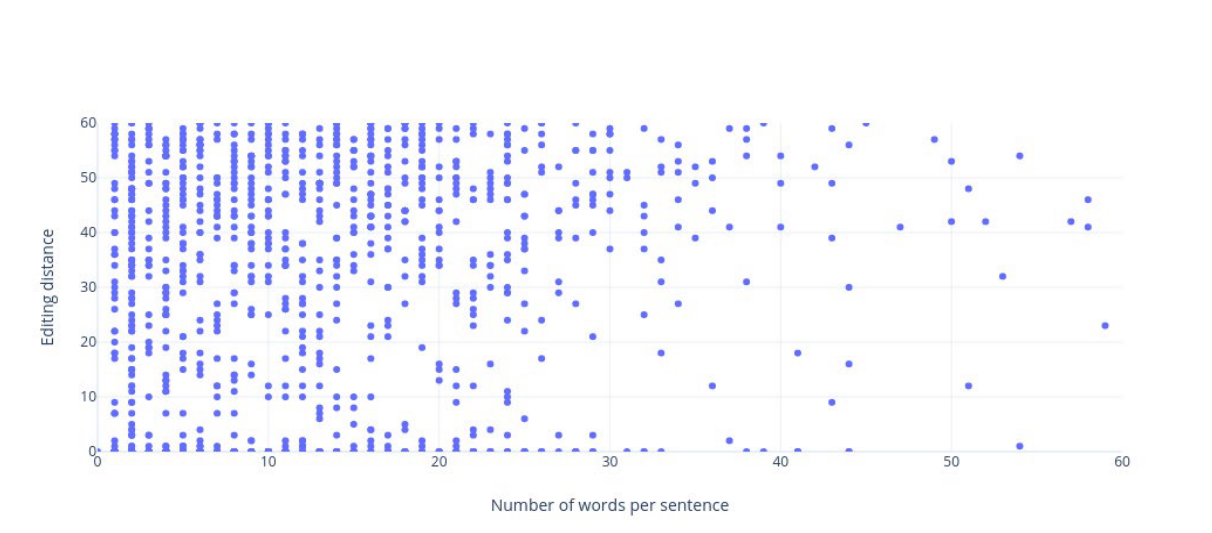
Figure 2 – Editing distance vs. number of words per sentence scattering